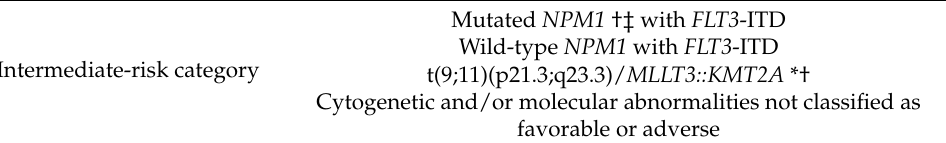
Table 2. 2022 European LeukemiaNet (ELN) risk classification by genetics at initial diagnosis. Adapted from